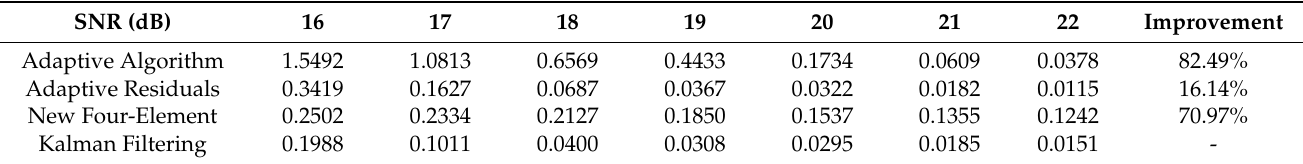
Figure 9. Comparison of the positioning accuracy of different methods with different SNR values. Table 4. The positioning accuracy of the four methods with a quaternary array.